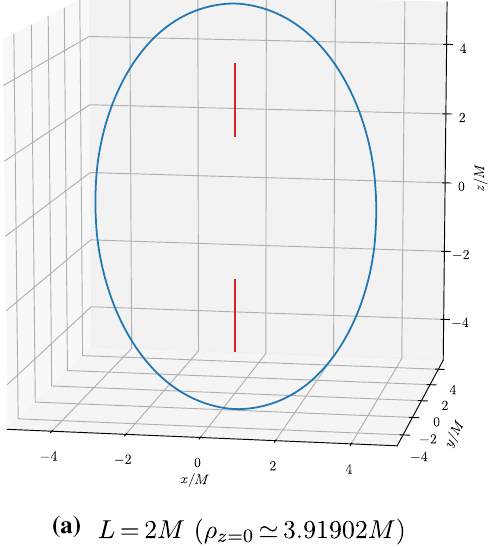
Fig. 5 Examples of polar FPOs, for two different values of L as indicated